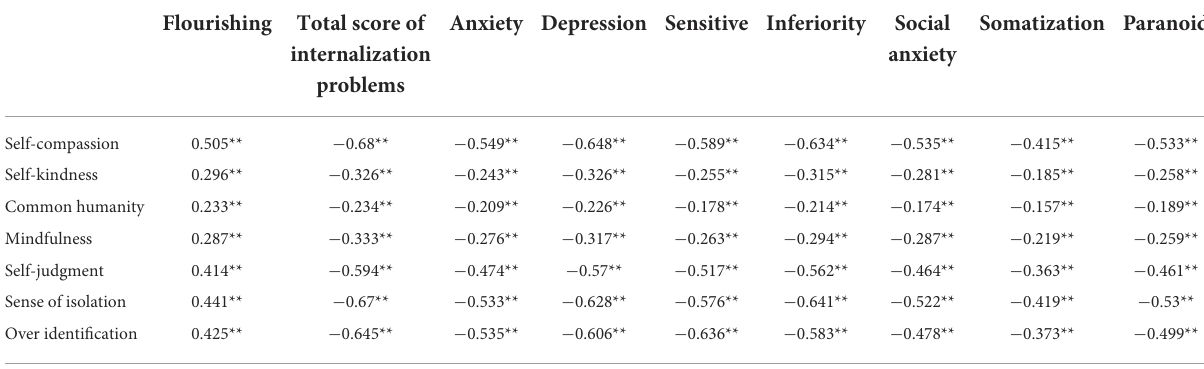
TABLE 7 Correlation between self-compassion and mental health.